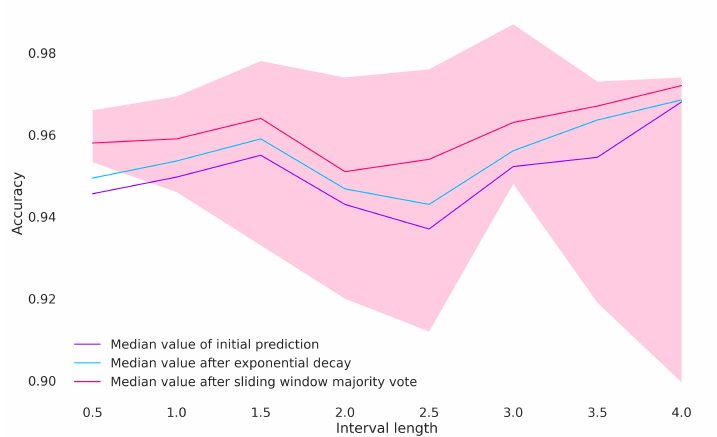
Figure 14. Accuracy over all gaits for each interval length (in seconds) using a rotation to the horse’s frame of reference. The blue and red lines show the result of post-processing the classification result to achieve a higher accuracy score. The shaded area is bounded by the highest and lowest reported accuracy for each interval after post-processing. The accuracy is averaged over 9 evaluations on the test set, where the model was trained using a different random seed each time.